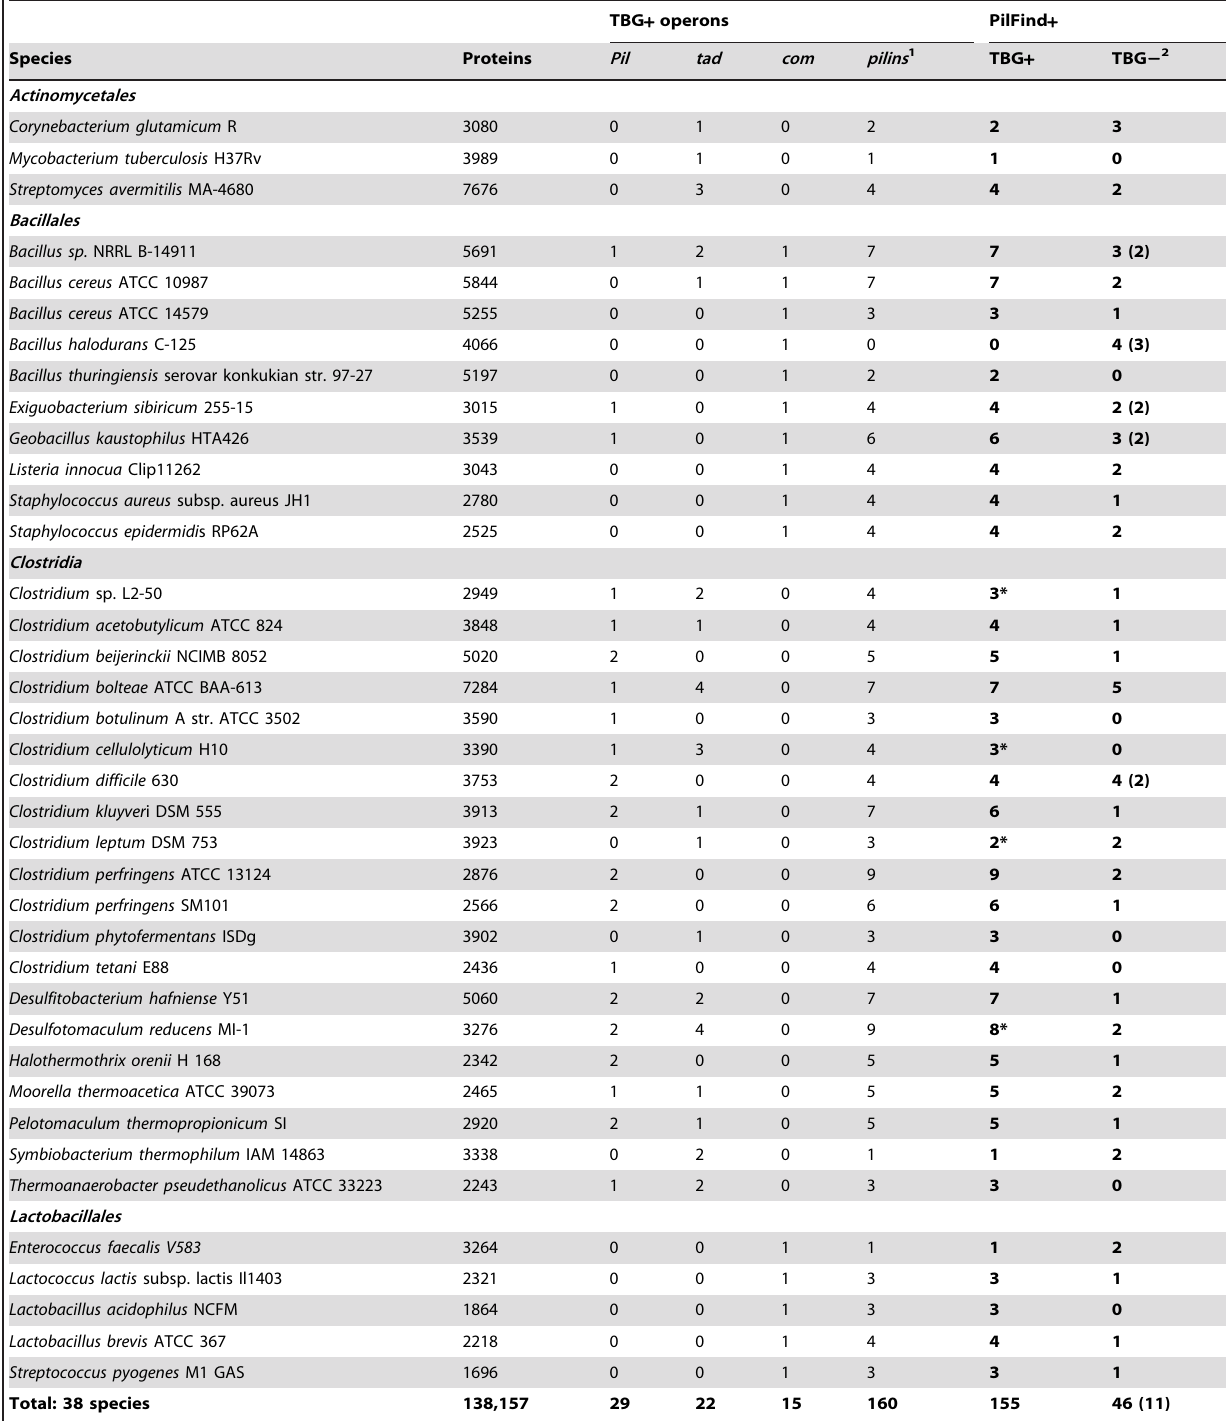
Table 4. Gram-positive type IV pilins identified by